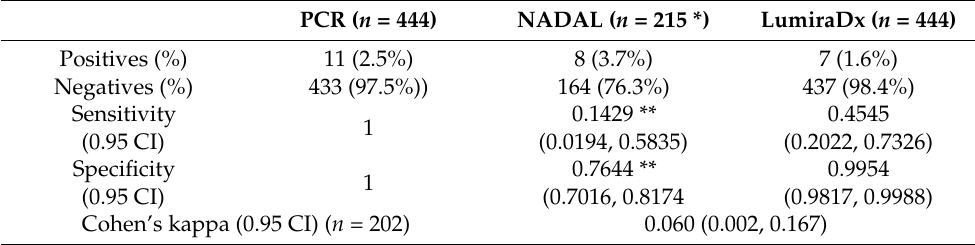
Table 1. Sensitivity, specificity and agreement between the two assessed antigen